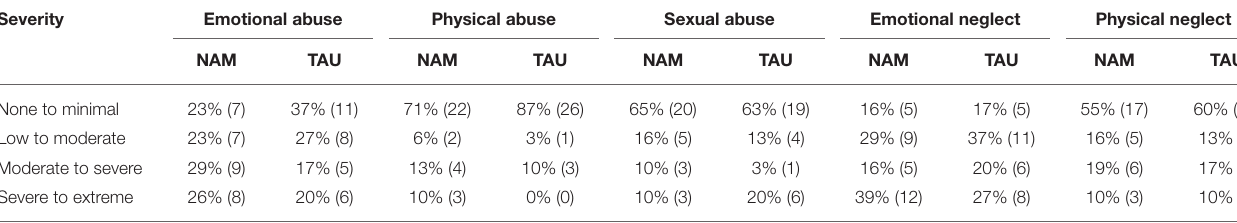
TABLE 3 | Dimensions and severity of childhood traumatization (CTQ) by group. Severity